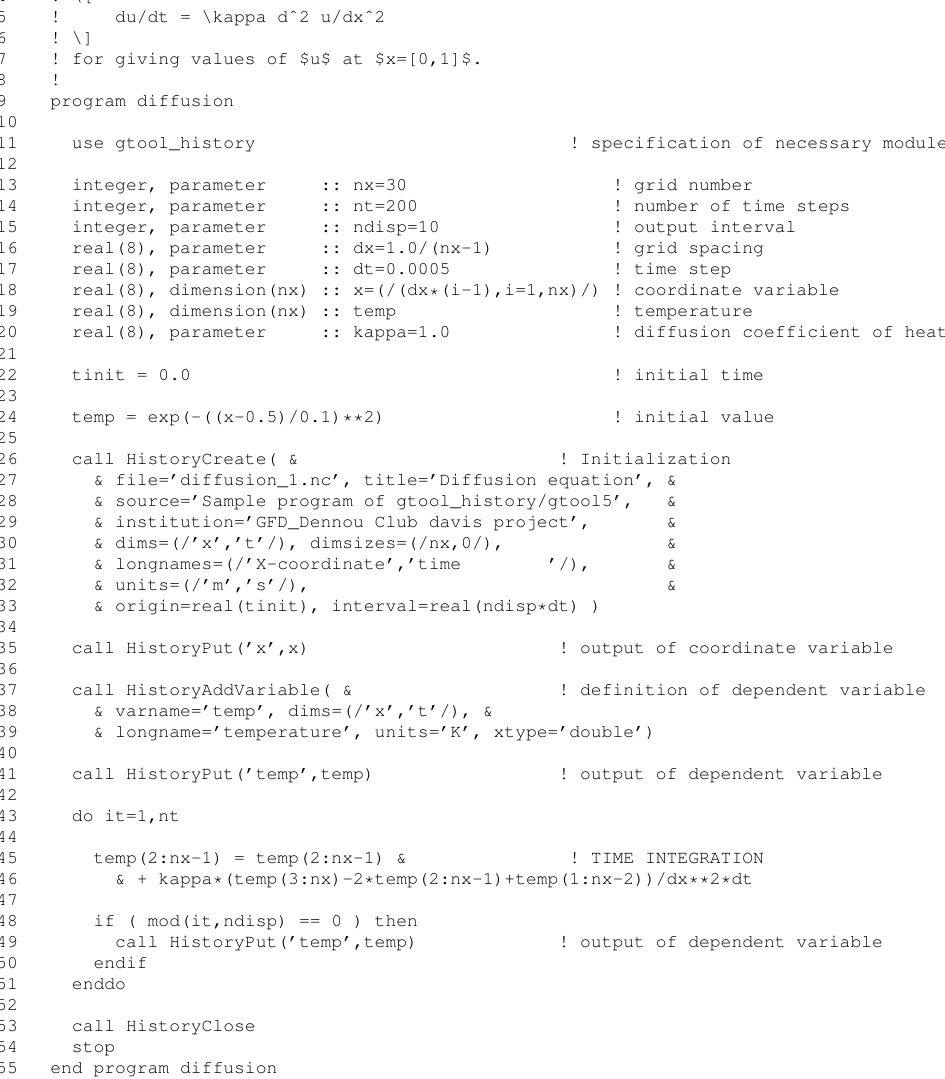
Fig. 1. An example of program source code of a numerical model using the gtool5 library. Numbers on the left-hand side indicate line numbers.